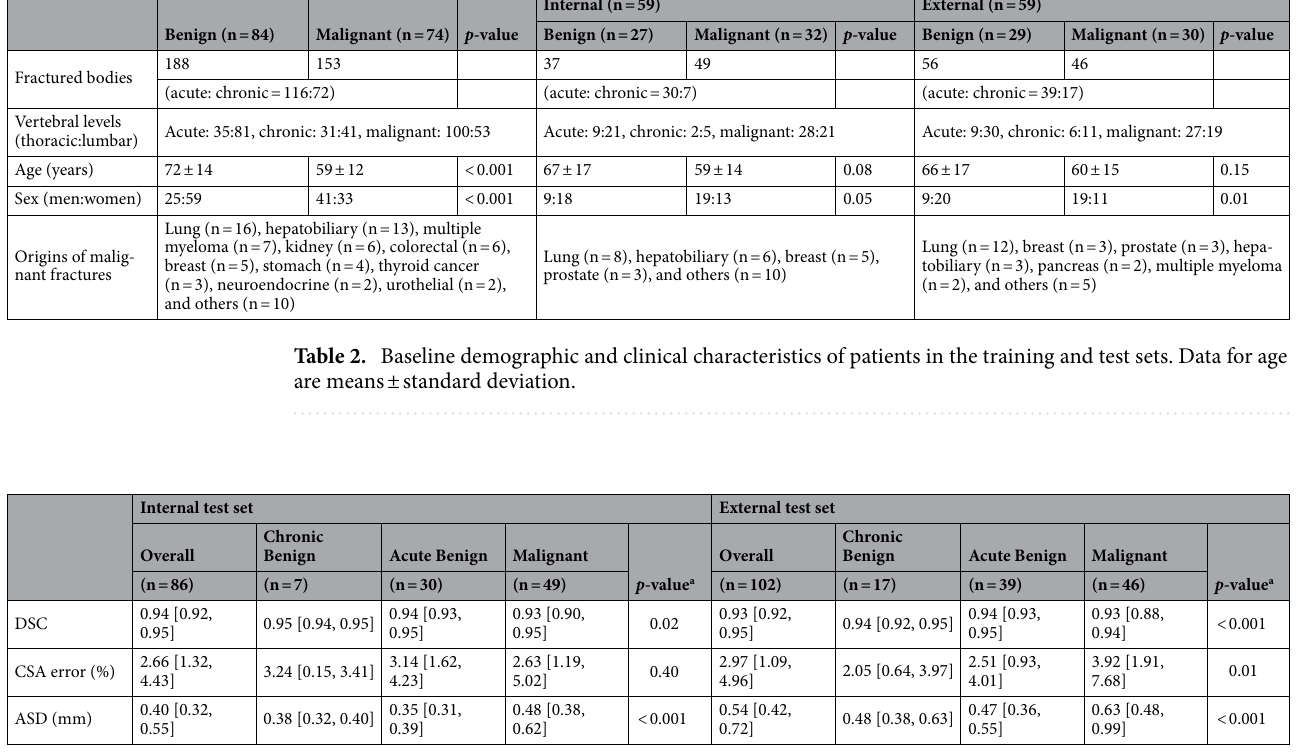
Table 3. Accuracy of automated segmentation algorithm for fractured vertebral body segmentation. All results are shown as median and interquartile ranges in brackets. DSC indicates dice similarity coefficient; CSA, cross-sectional area; ASD, average surface distance. a p-value for comparison between chronic benign, acute benign and malignant